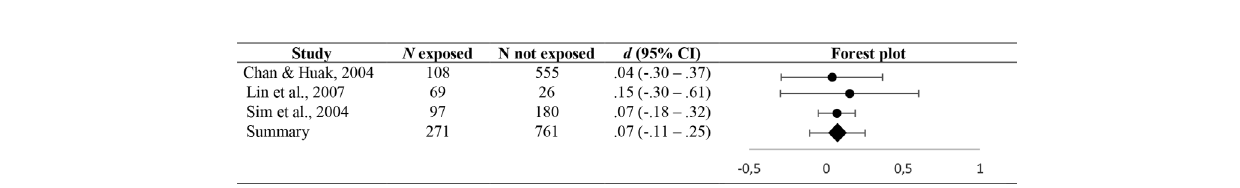
FIGURE 2 | Forest plot of overall psychiatric symptoms.